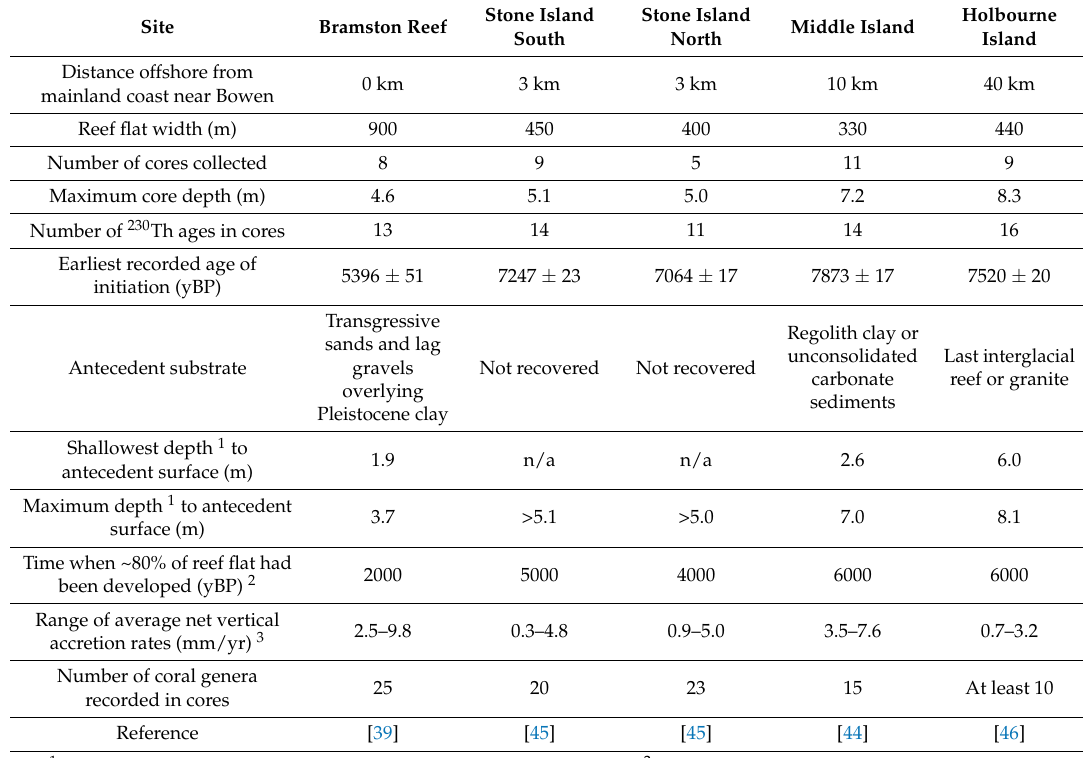
Table 1. Summary of Holocene reef growth attributes at the study reefs. 230 Th ages are presented as years before present (1950